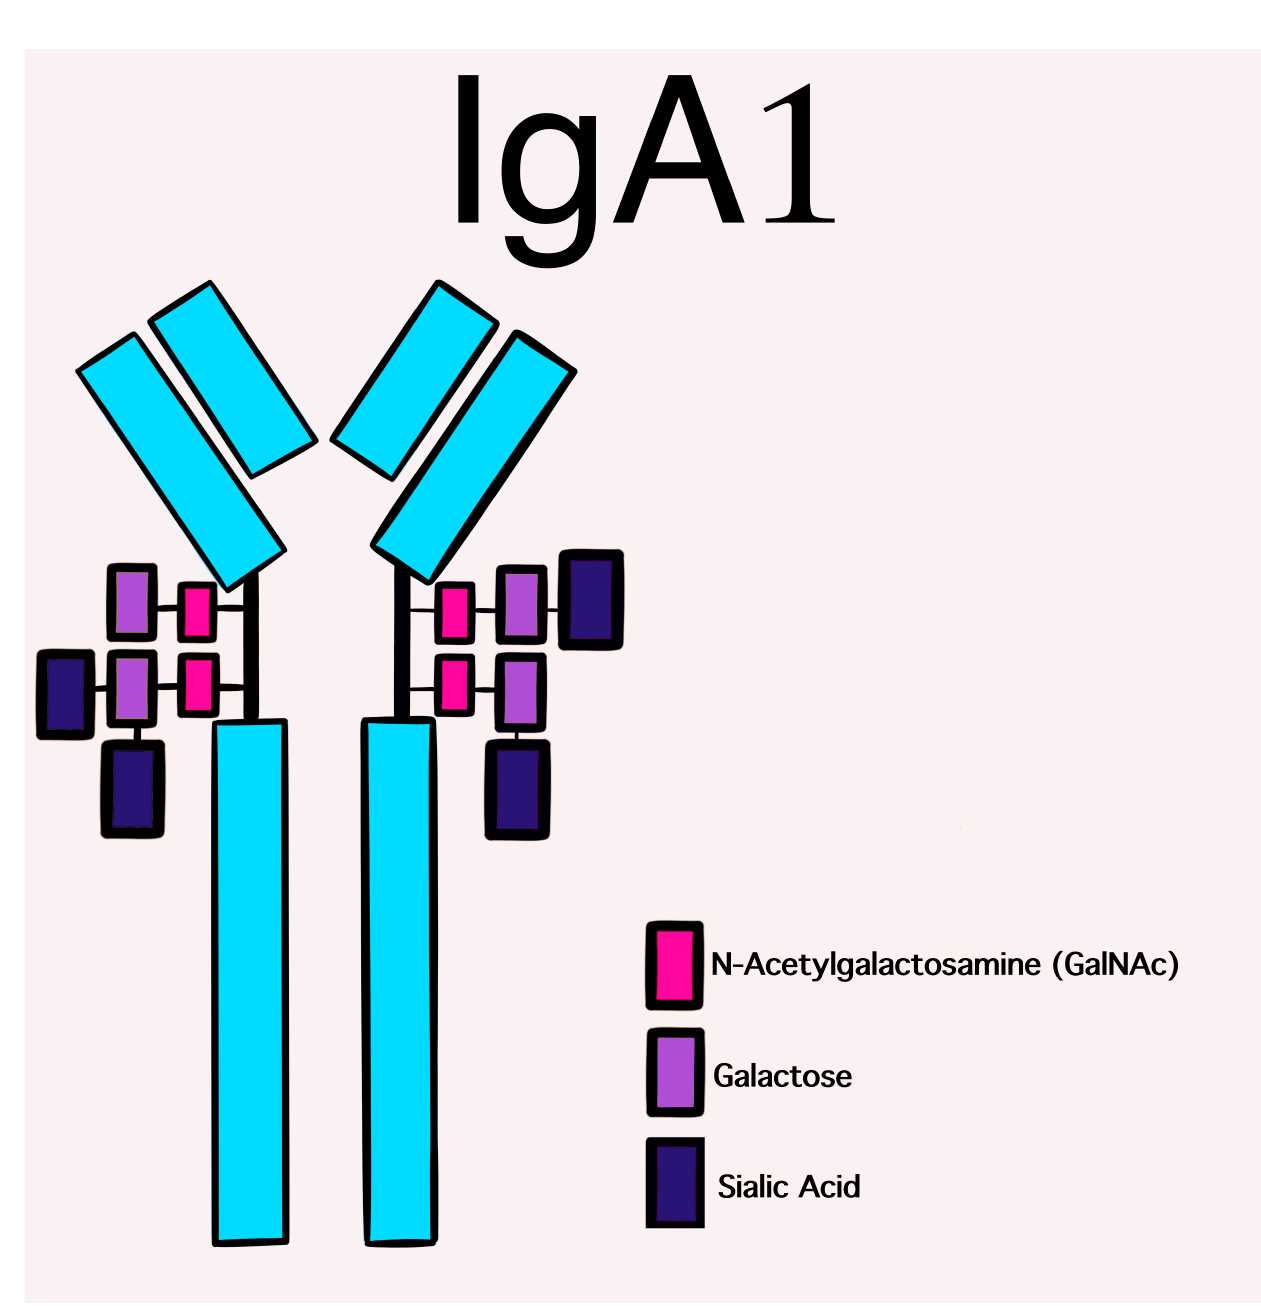
Figure 1. Schematic picture of a normal IgA1 containing GalNAc ‐ galactose disaccharide and its mono ‐ and di ‐ sialylated forms in the hinge region of the heavy chains.